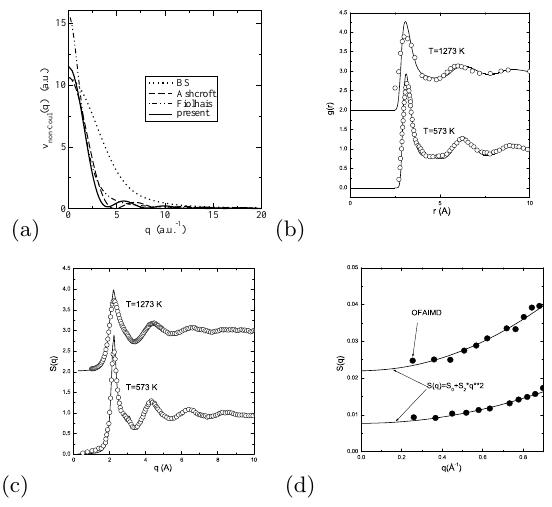
Fig. 1. (a) Bare non-Coulombic electron-ion interaction in momentum space for different pseudopotential models. (b) Pair correlation functions at 573 K and 1273 K. Line: simulation data, circles: experimental values. (c) Static structure factor S(q), same meaning of symbols. (d) Least square fit to the S(q) at low q.